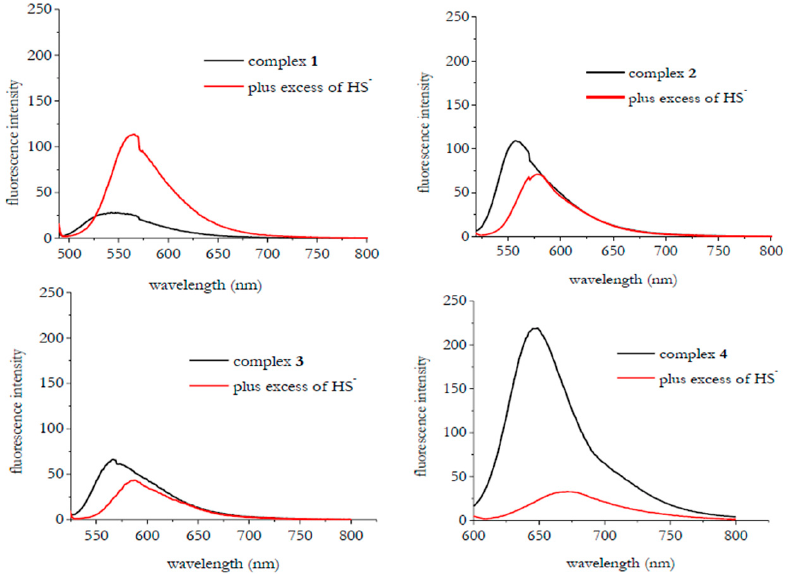
Figure 2. Emission spectra of complexes 1 − 4 before and after the addition of 5 equiv of NaSH. [Complexes 1 − 4 ] = 1 × 10 − 5 M; [NaSH] = 5 × 10 − 5 M. All spectra were measured in DMSO with λ exc = 481 nm for complex 1 ; λ exc = 513 nm for complex 2 ; λ exc = 516 nm for complex 3; λ exc = 598 nm for complex 4 .